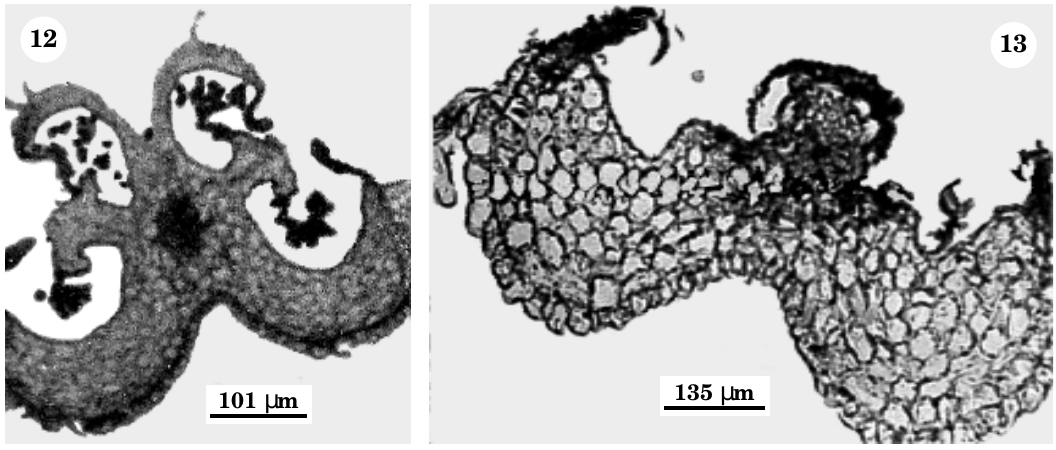
Fig. 12-13. Cross sections of anther of Marmande tomato flower infected with TMV-M showing the general form of infected anther (12), hook-like structure of infected anther